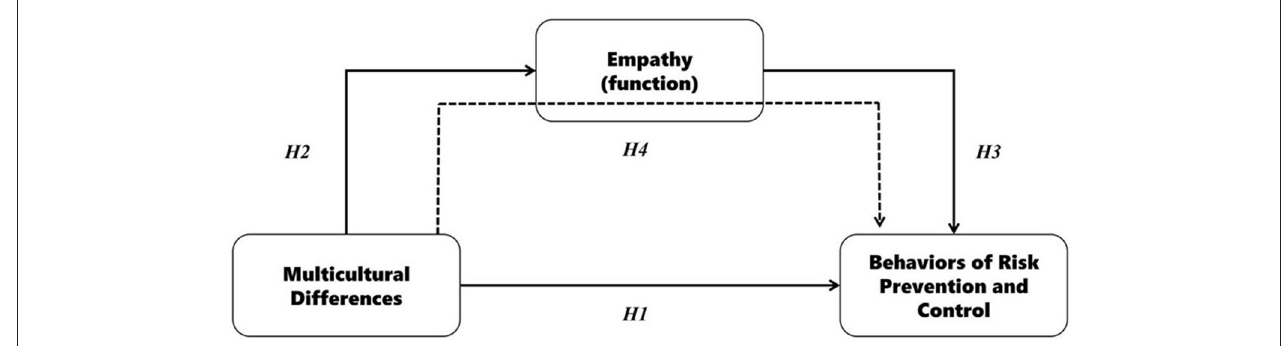
FIGURE 1 | Research hypothesis